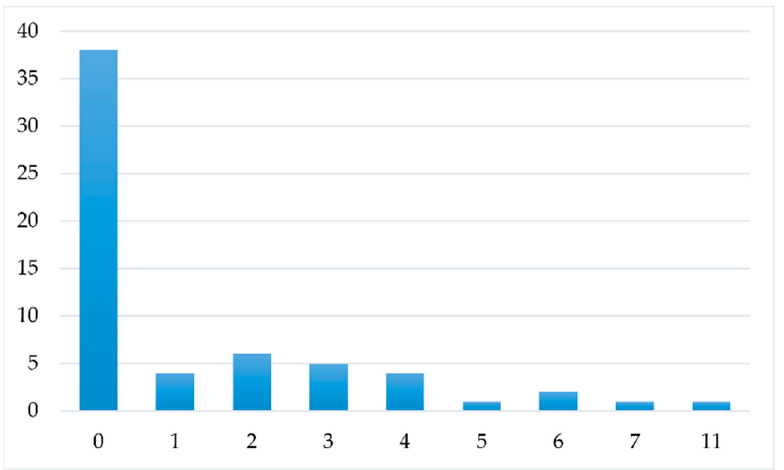
Figure 12. Number of intelligent methods against which each predictive model is benchmarked.